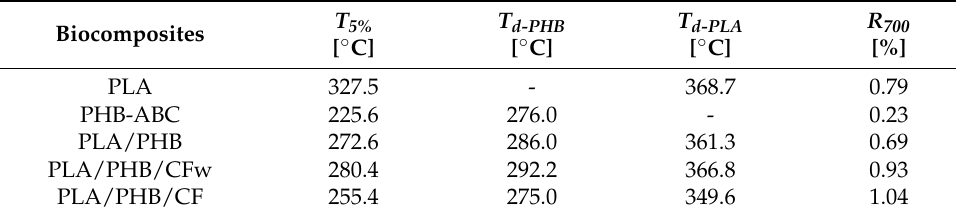
Figure 2. TGA ( a ) and DTG ( b ) curves of PLA, PHB-ABC, PLA/PHB, and biocomposites. Table 2. Thermal degradation characteristics of PLA/PHB